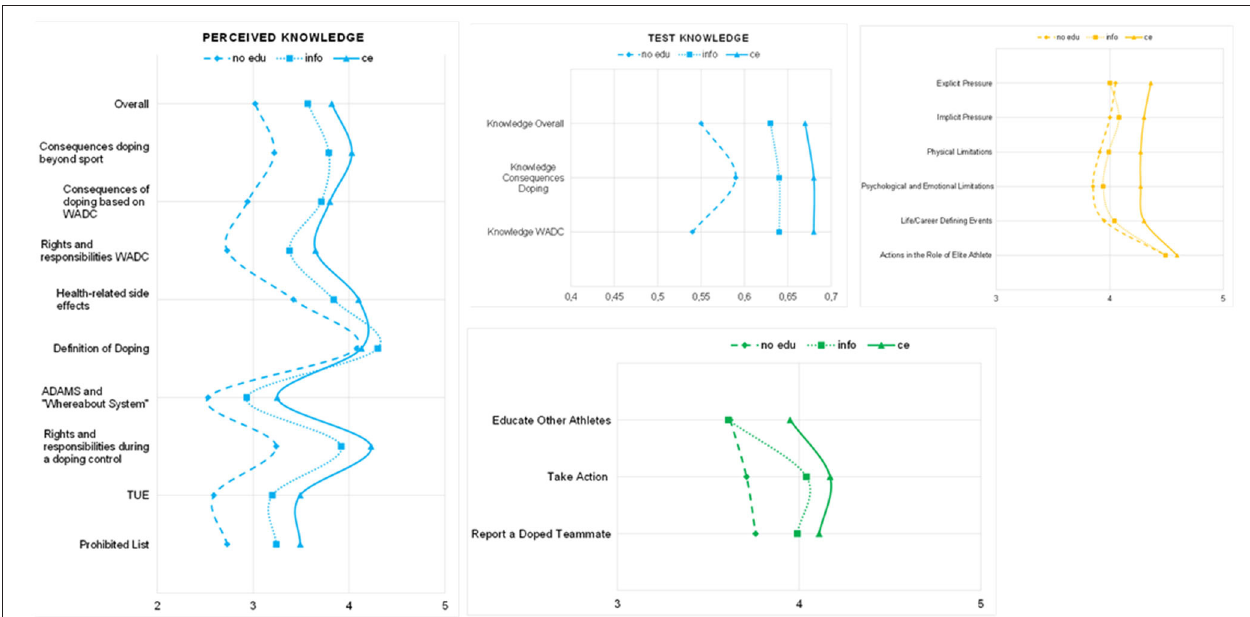
FIGURE 6 | The DAL stages. Functional Literacy: blue; Minimum–Maximum Perceived Knowledge: 1–5; Minimum–Maximum Test Knowledge: 0–1 → figures are scaled to provide more detailed information; PK, perceived knowledge; WADC, World Anti-Doping Code; TUE, Therapeutic Use Exemption; ce, comprehensive education. All changes were significant. For details on p -values and post-hoc tests, refer to Supplementary Table 5 . Interactive Literacy: orange; Minimum–Maximum: 1–5; → figure is scaled to provide more detailed information; ce, comprehensive education. All changes were significant except for “Actions in role as an elite athlete.” For details on p -values and post-hoc tests, refer to Supplementary Table 5 . Critical Literacy: green; Minimum–Maximum: 1–5; → figure is scaled for more detailed information; ce, comprehensive education. All changes were significant. For details on p -values and post-hoc tests, refer to Supplementary Table 5 .